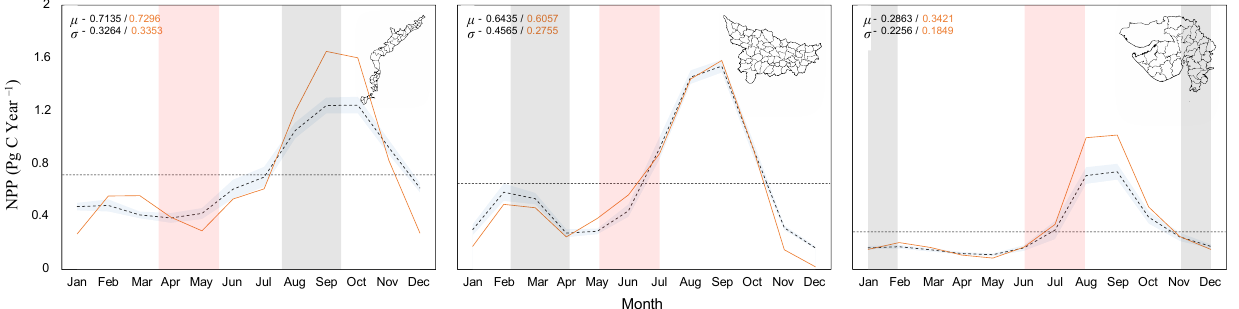
Figure 6. Climatology of monthly mean NPP against AOD for the possible sensitive zones of the respective ecological regimes (ECP, MGP, and GP). The dashed black line with shading represents the overall monthly mean NPP with uncertainty. The red line indicates the monthly mean NPP for the sensitive zones. The horizontal black dashed line represents the mean NPP for the region. The black and red shades indicate the temporal span of the lowest and highest observed AOD,